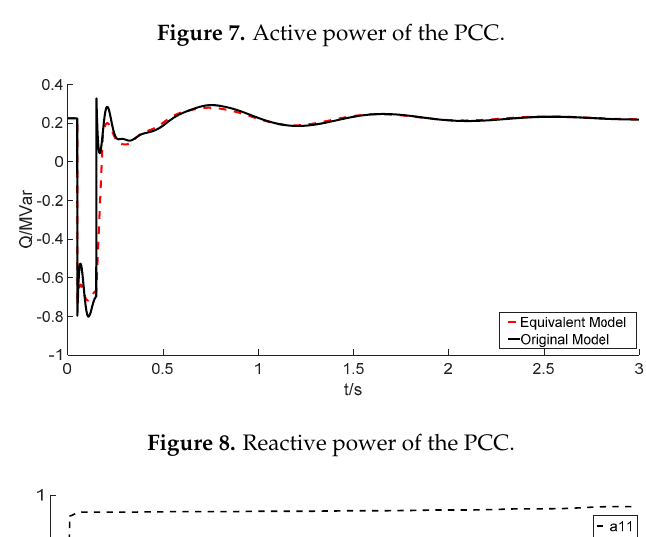
Energies 2017 , 10 , 1951